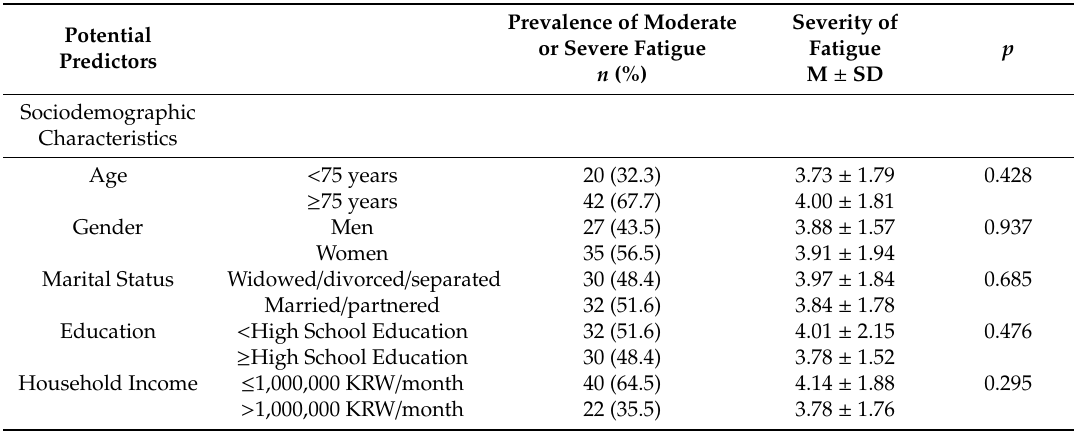
Table 1. The prevalence and severity of fatigue by sociodemographic, clinical, and psychological characters, and eating context in older adults with diabetes ( n =